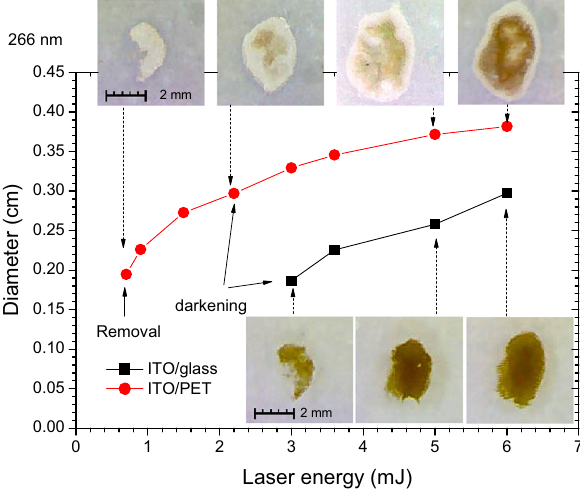
Figure 2: The diameter of the ablated area at di ff erent laser energies for ITO/glass and ITO/PET by 266 nm, ns laser.